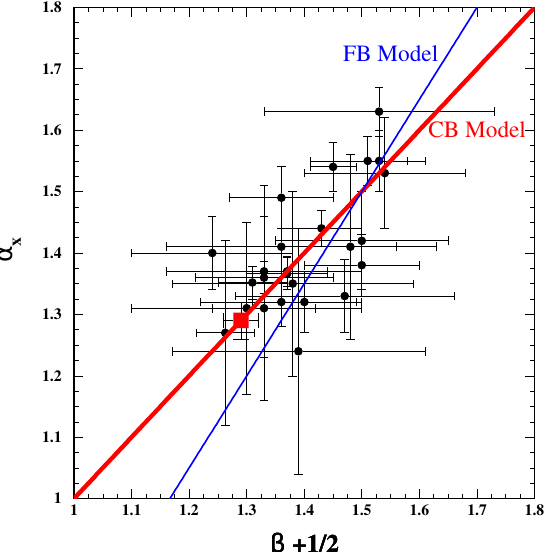
Figure 16. The values of the post-break temporal index α x as a function of the spectral index β x + 1/2 for the 28 most intense GRBs with known redshift [101] obtained from the follow-up measurements of their 0.3–10 keV X-ray AG with Swift’s XRT [95,96]. The square indicates the result for GRB 130427A. The thick line is the CB model prediction Equation (14), the thin one is the FB’s model. The models have similar χ 2 /dof but 3/4 of the points lie above the FB-model